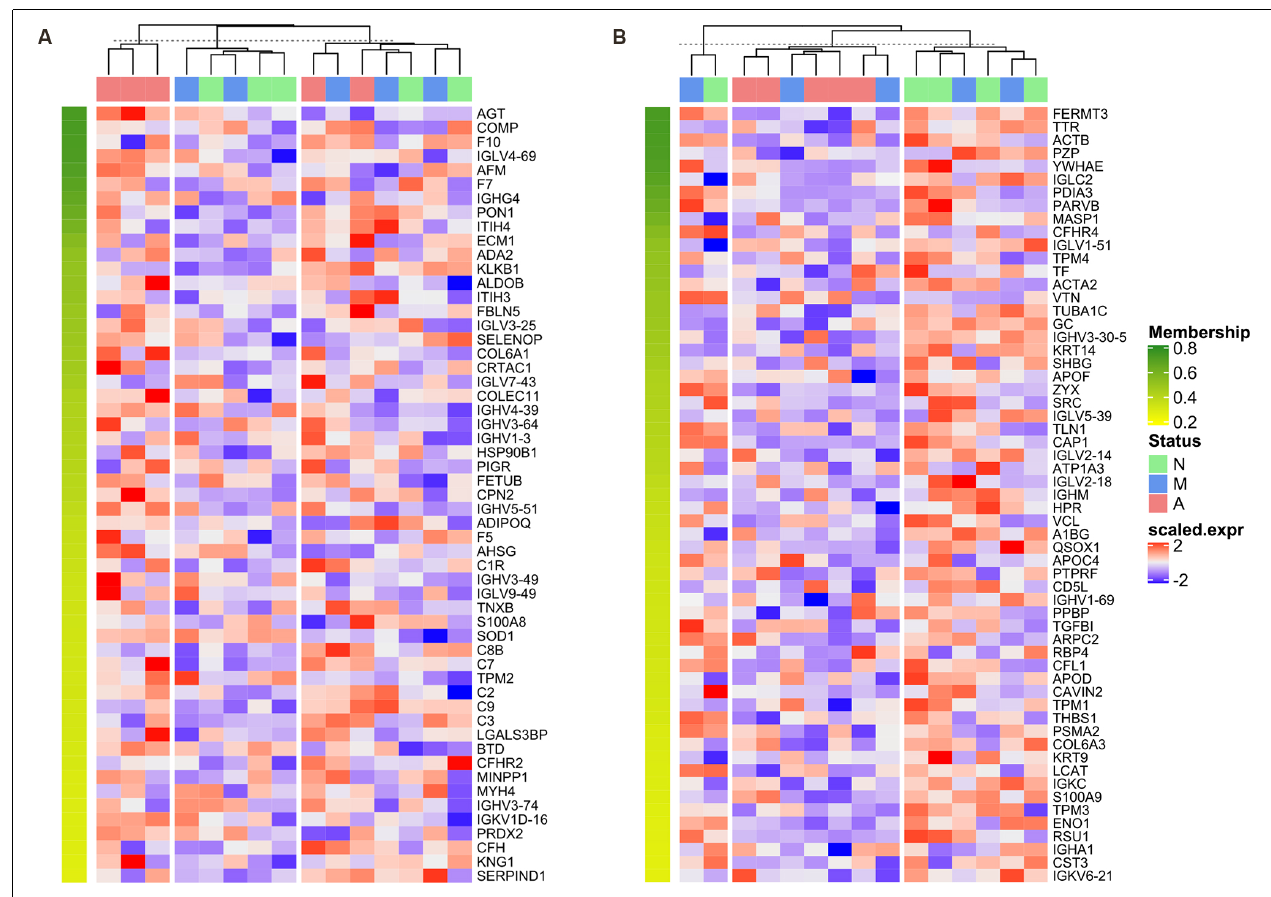
FIGURE 6 | Heatmap of normalized expression matrix of two clusters. The expression matrixes of bridge proteins in Cluster 4 (A) and Cluster 5 (B) visualized as a heatmap. The dendrogram at the top of the heatmap was generated by K-means clustering based on the expression profile of 55 Cluster 4 bridge proteins/59 Cluster 5 bridge proteins, whereby samples were divided into 3 clusters. The bridge proteins were sorted in descending order according to the corresponding cluster membership; therefore, the membership value decreases from top to bottom of the row annotation (as represented by a color gradient from green to